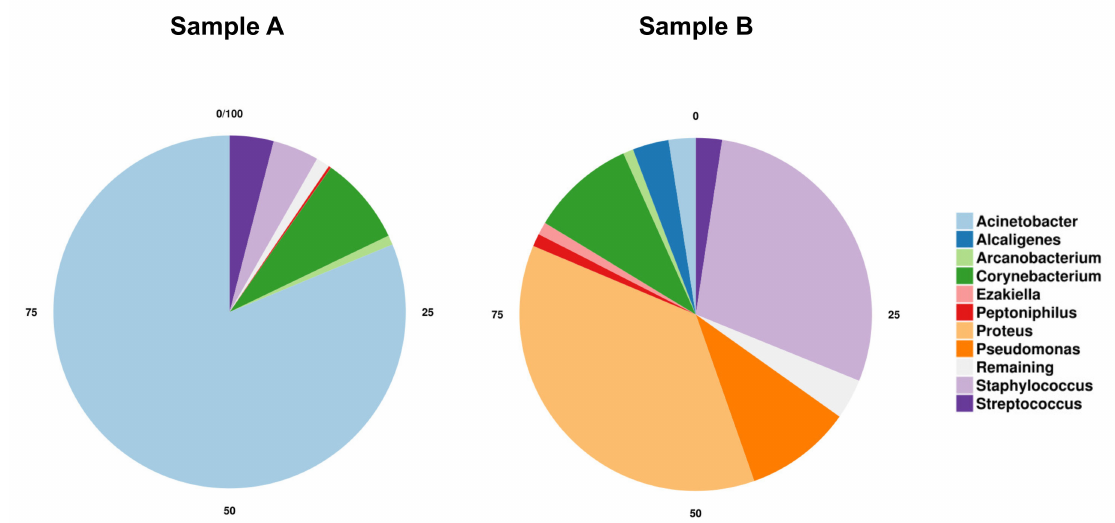
Figure 3. Distribution of the Top 10 most abundant taxa found in samples from Patients A and B at the genus level. The most abundant genera in Patient A sample comprise Acinetobacter in light blue (81.2%), Corynebacterium in dark green (8.1%), Staphylococcus in light purple (4.2%), and Streptococcus in dark purple (4%). The most abundant genera in Patient B sample comprise Proteus in light orange (36.7%), Staphylococcus in light purple (28.7%), followed by Pseudomonas in dark orange (9.8%) and Corynebacterium in dark green (9.6%).